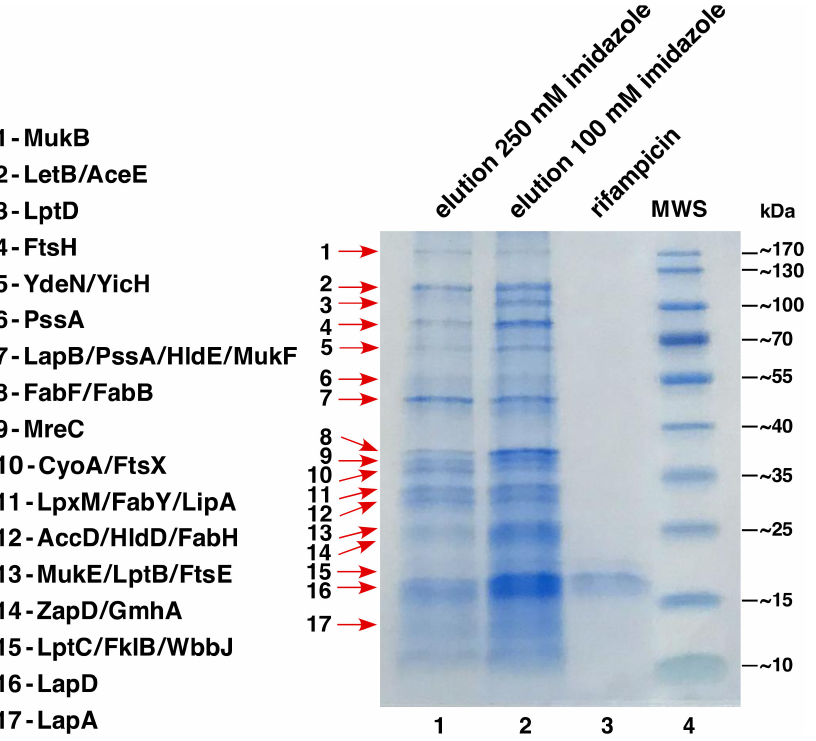
Figure 4. LapD forms a complex in the IM with proteins involved in LPS and phospholipid biosynthe- sis. Purification profile of His 6 -tagged LapD protein from the IM fraction after elution with 250 mM and 100 mM imidazole (lanes 1 and 2, respectively). Lane 3 shows the migration of His 6 -tagged LapD protein obtained after rifampicin treatment during the induction of its synthesis. All major co-purifying proteins are indicated by arrows. Proteins were resolved on a 12% SDS-PAGE, stained by Coomassie Brilliant Blue. Lane 4 shows pre-stained molecular weight